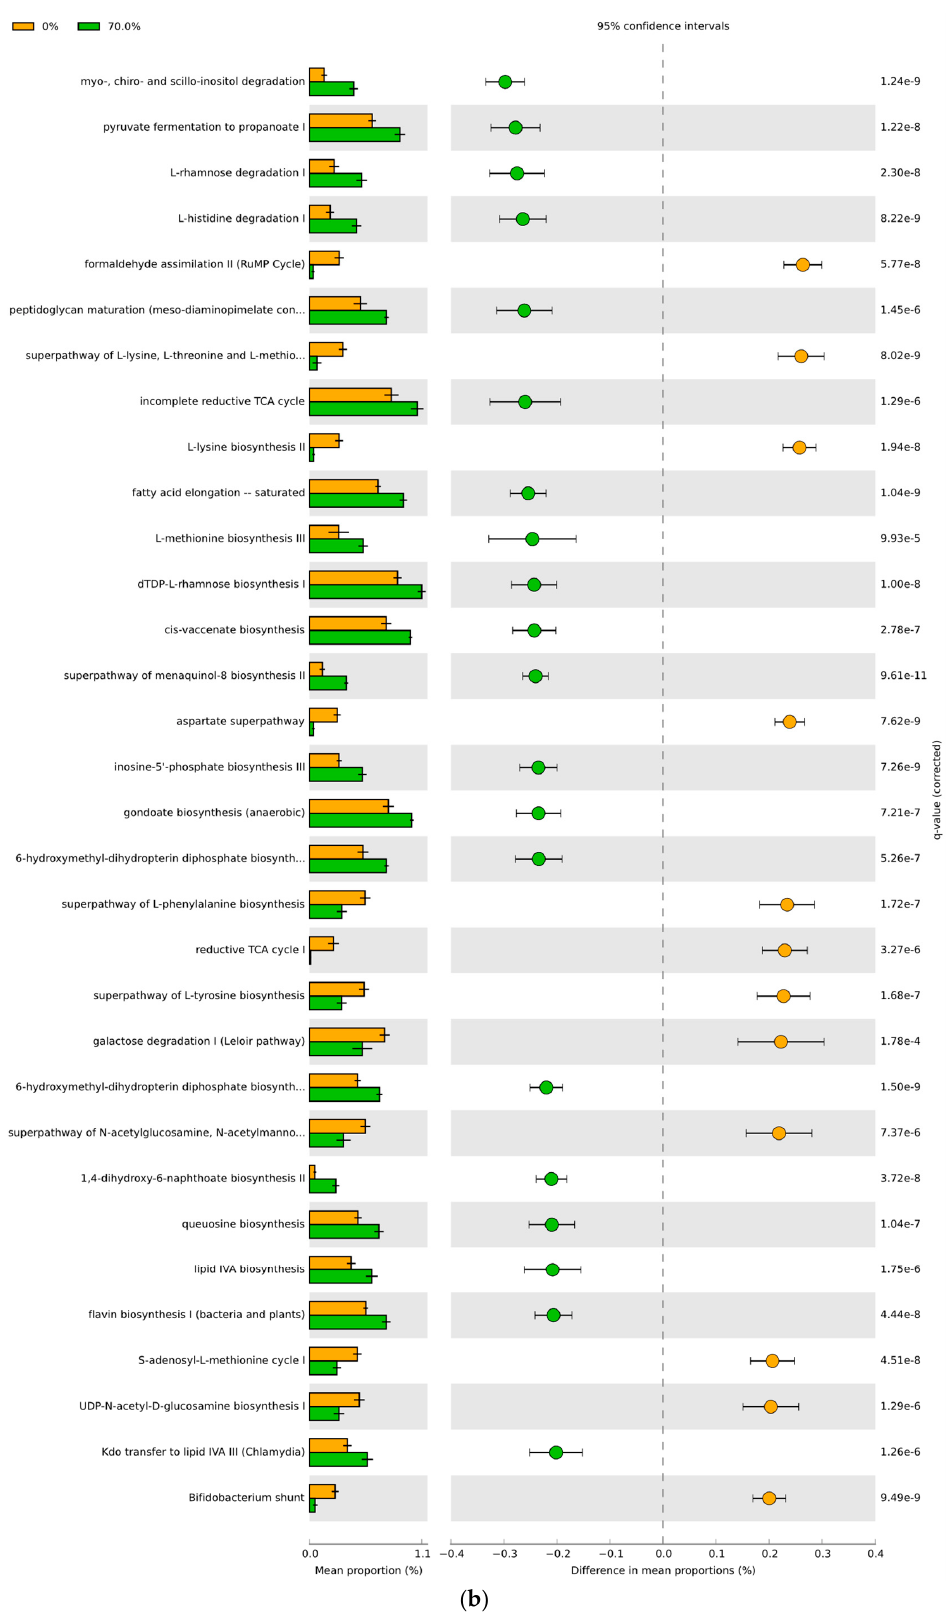
Figure 9. PICRUSt2 results indicating differential predicted functional pathways with 20% of the difference in the mean proportions between the bean-free and the bean-containing diet groups